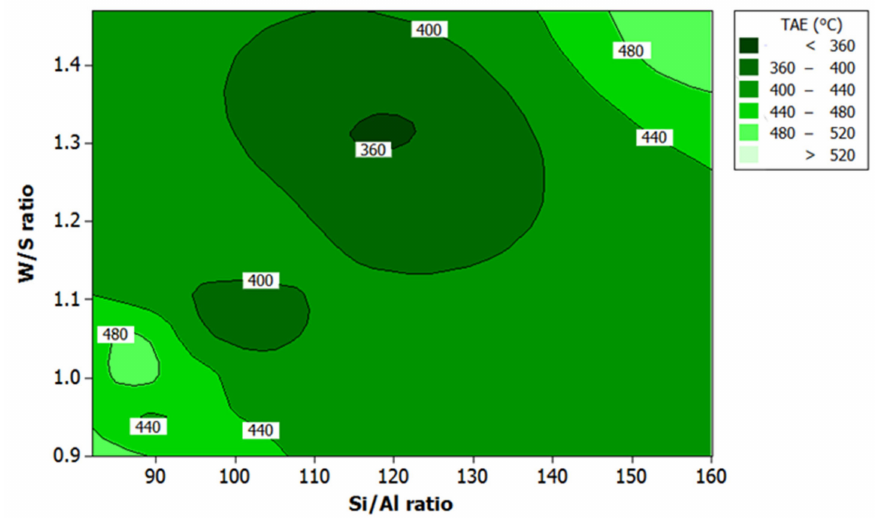
Figure 9. Contour plot for the effect of W/S ratio and Si/Al ratio on the TAE in fire-retardant